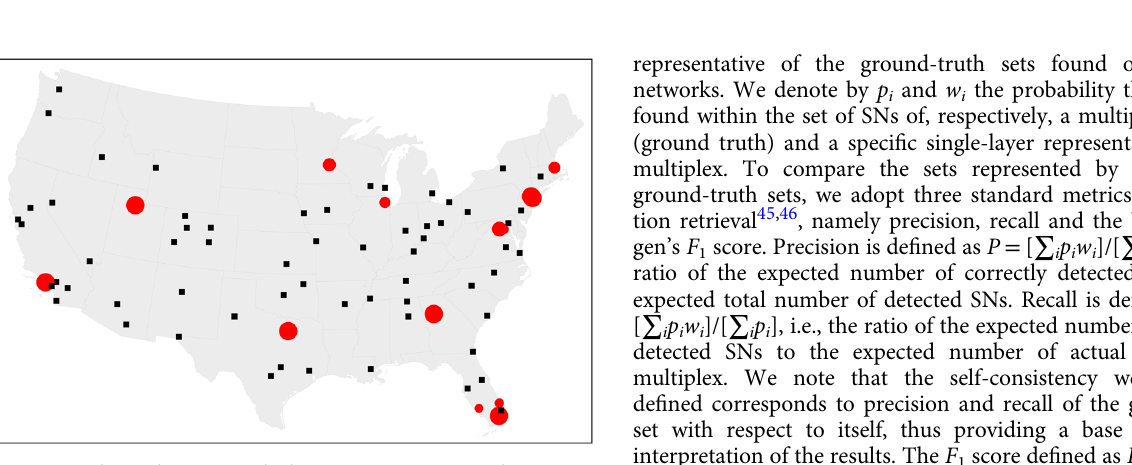
Fig. 5 Optimal percolation on multiplex transportation networks. We consider the multiplex network of US domestic fl ights operated in January 2014 by American Airlines and Delta. Red circles represent nodes that were identi fi ed as members of the set of structural nodes in different realizations of the optimal percolation on the multiplex representation of the network. The size of each circle is proportional to the probability of fi nding that node in the set of SNs. All other airports in the multiplex are represented as black squares. Interestingly, not all the 14 structural nodes match the top 14 busiest “ hubs ”